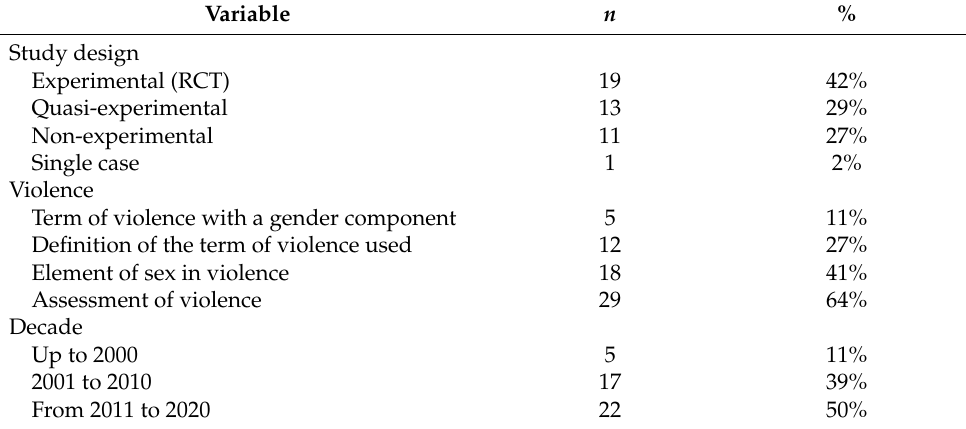
Table 1. Study characteristics.